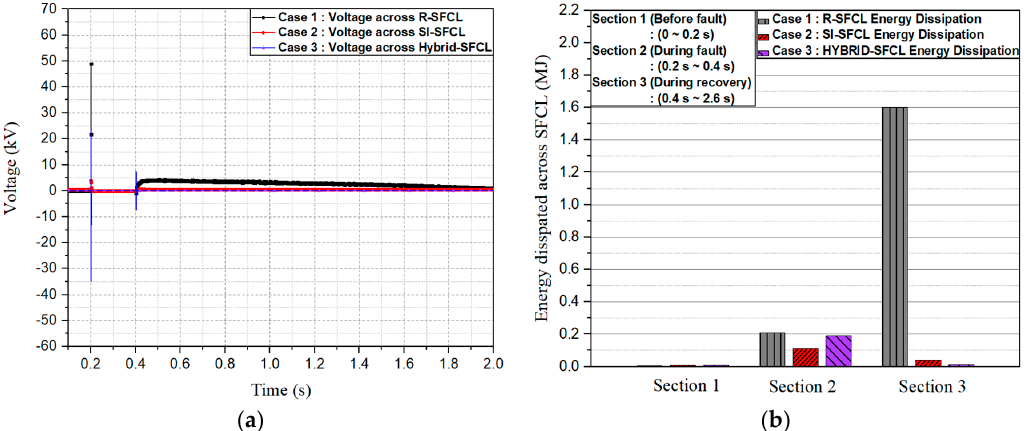
Figure 15. The comparison of voltage and energy dissipation across SFCL: ( a ) voltage waveform across SFCL; ( b ) energy dissipation across SFCL.